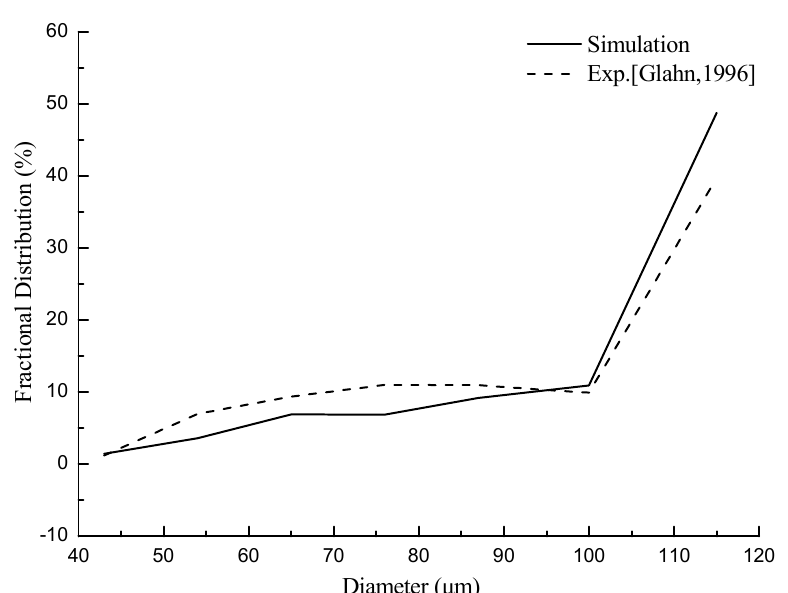
Figure 4. Comparison and verification of oil drop size distribution.